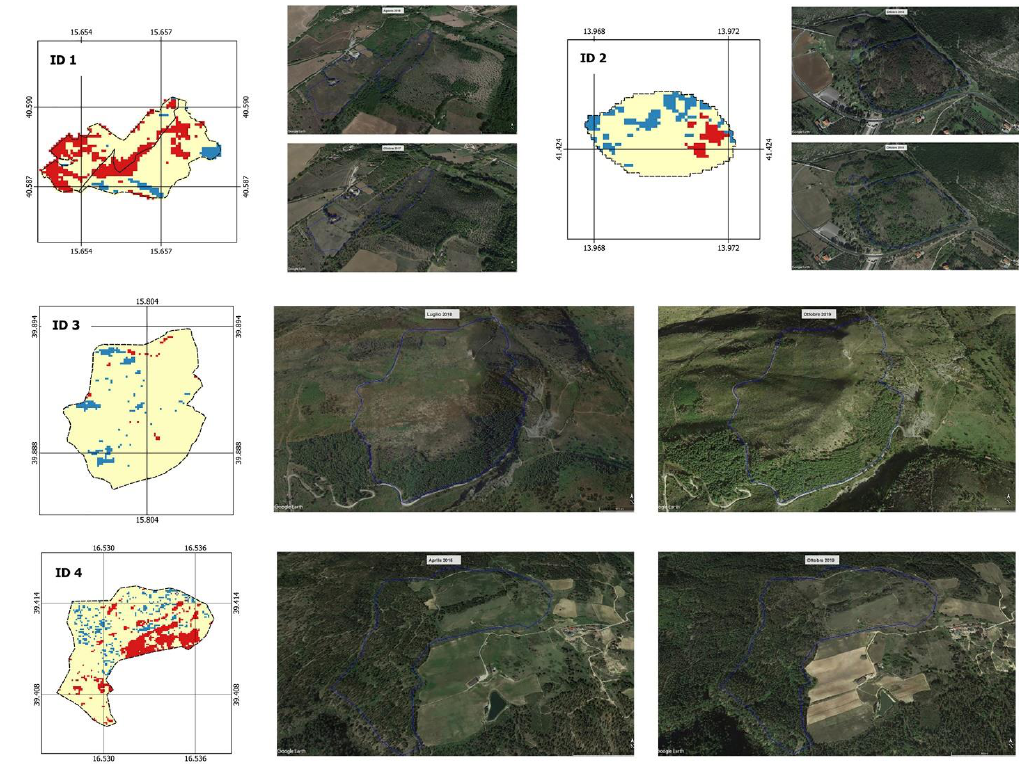
Figure 9. Events 1–4 (referring to IDs in Table 1) and comparison with high-resolution images from Google Earth.